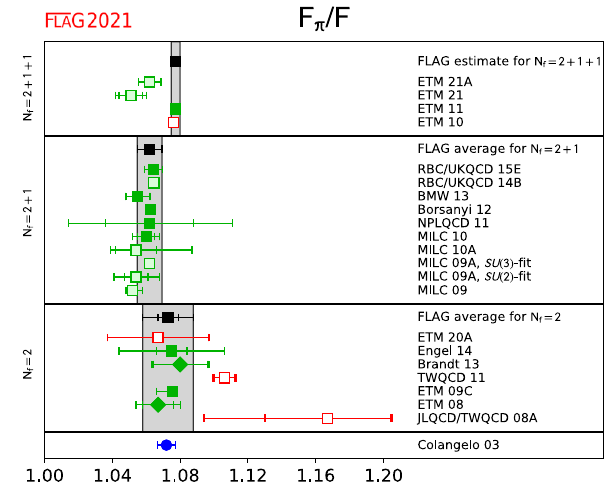
Fig. 15 Comparison of the results for the ratio of the physical pion decay constant F π and the leading-order SU ( 2 ) low-energy constant F . Square symbols indicate determinations from correlators in the p -regime, and diamonds from the pion form